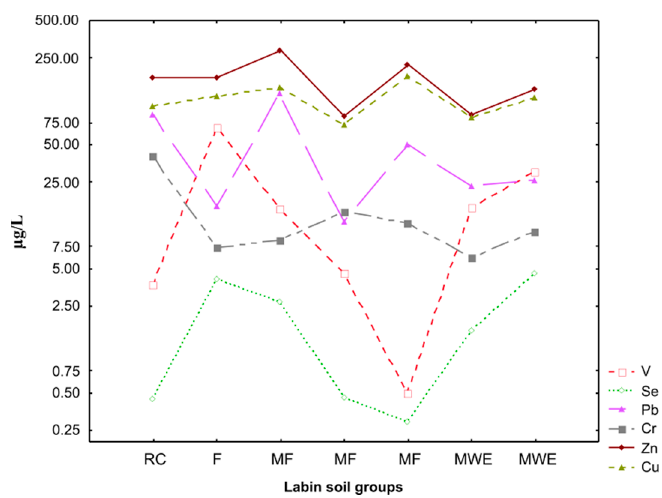
Figure 4. Line plots of element concentrations (µg/L) measured in selected water-extracted soil samples: RC—soil polluted with Raša coal debris, F—soil overlying an old ash/foundry waste landfill, MF—soil polluted mostly by metal factory, and MWE—soil close to a municipal wastewater effluent channel.